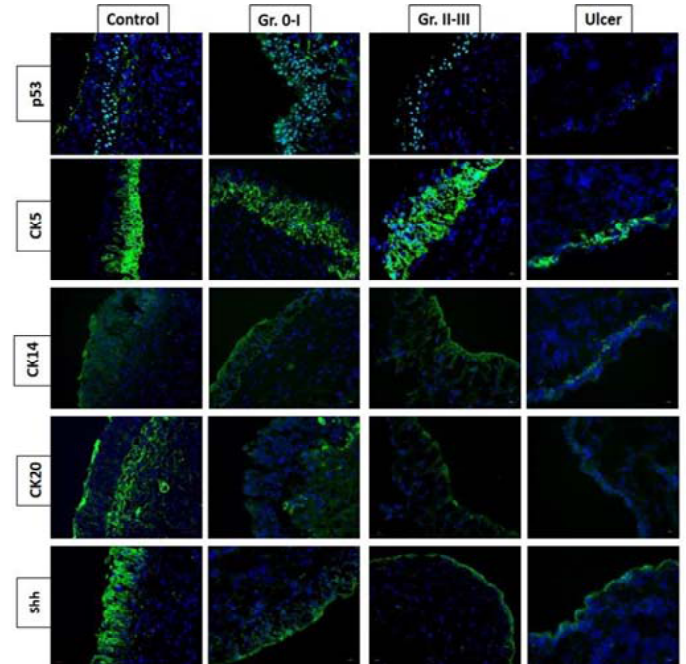
Figure 1. Expression of p53, CK5, CK14, CK20, and Shh proteins varies in different phenotypes of interstitial cystitis/bladder pain syndrome (IC/BPS). Hunner’s IC/BPS bladders had a low pro- liferative and differentiation ability, whereas the other non-Hunner’s IC/BPS bladders also had deficit proliferative and differentiation ability, both of which were also associated with the grade of glomerulations under